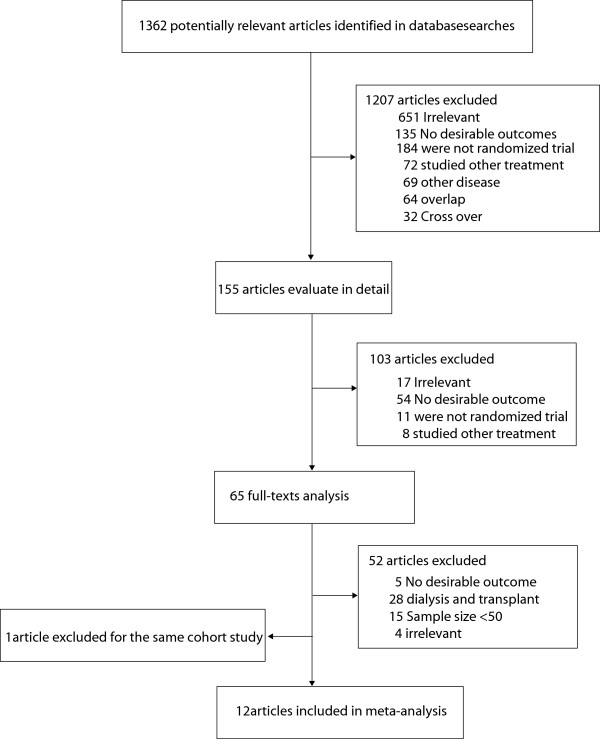
Flow diagram of the literature search and selection process.